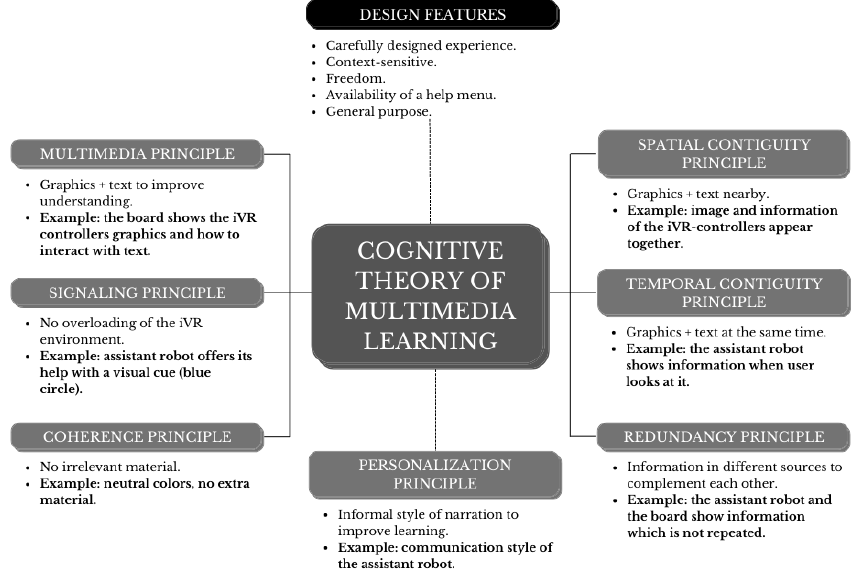
Figure 1. Design features of the iVR tutorial.